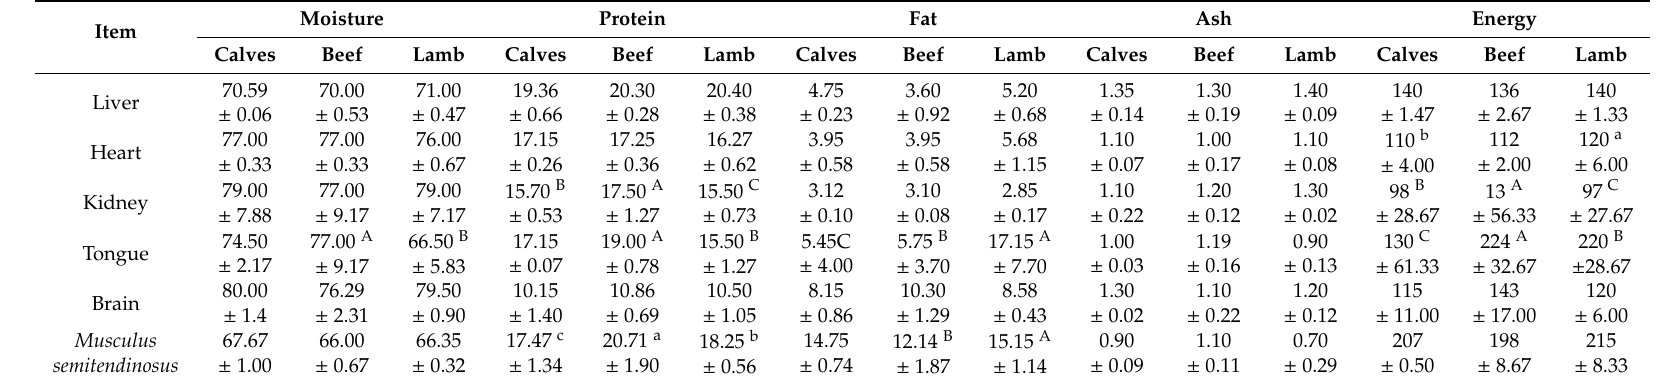
Table 1. Chemical composition (% of wet tissue) and energy value (kcal / 100 g) of the tested organs (mean ± s.e.).